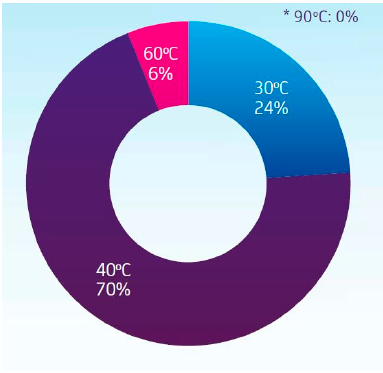
Figure 9. Washing machine temperature distribution as per users [13].